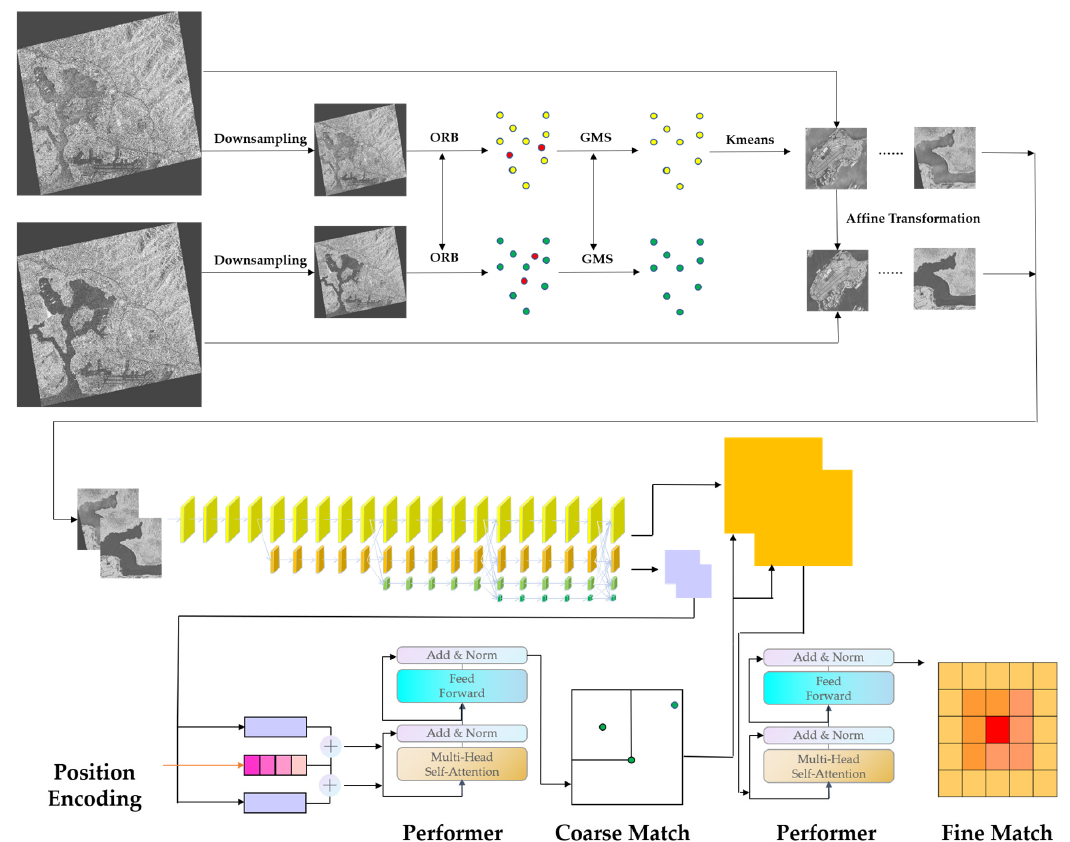
Figure 2. The pipeline of the proposed